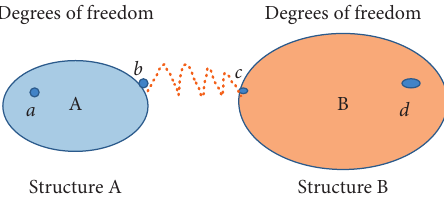
Figure 3: Dynamic substructure separation state.